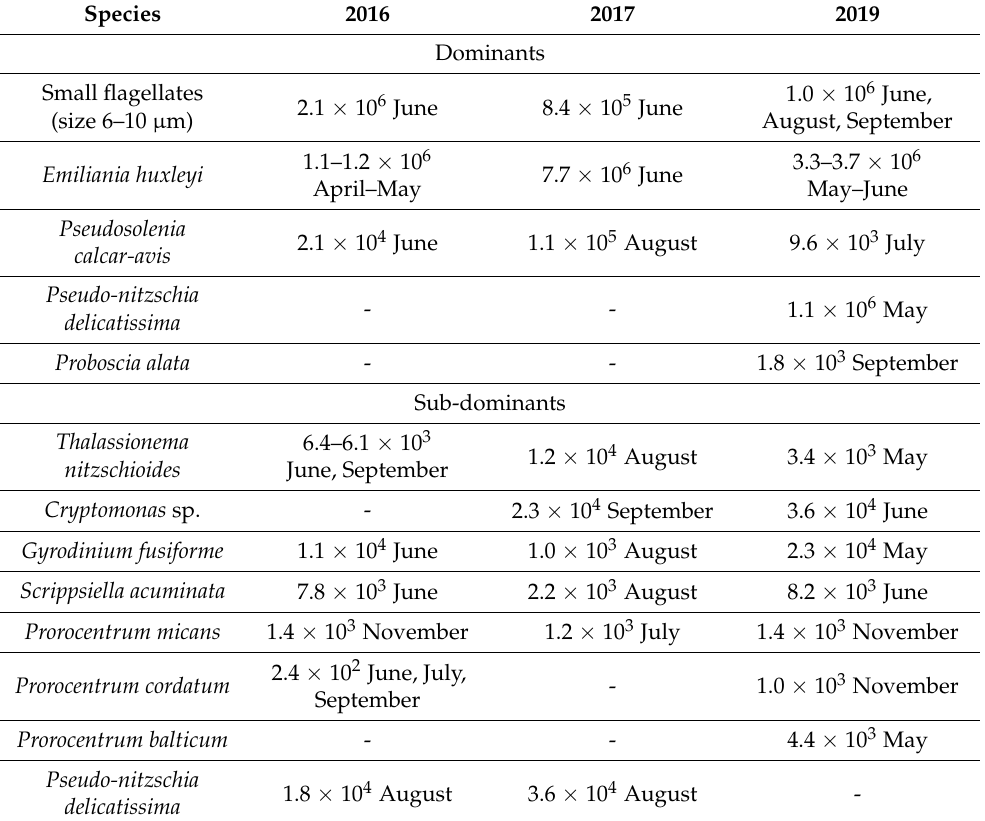
Table 2. Abundance (cells L − 1 ) of dominant phytoplankton species in 2016, 2017, and